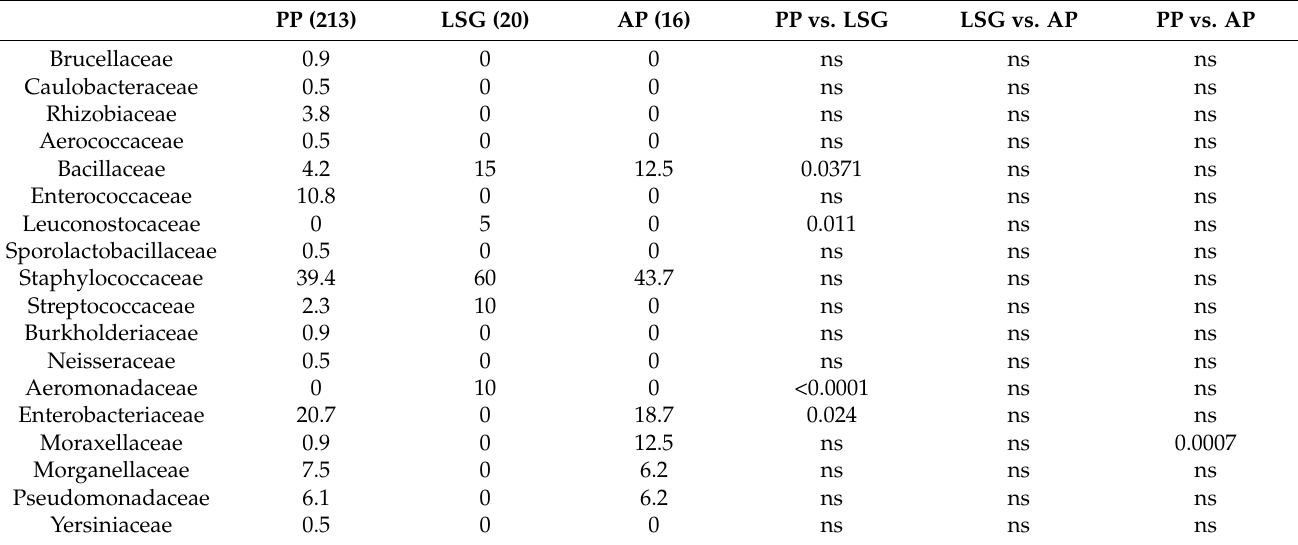
Table 3. Relative abundance (%) of cultivable bacteria at the family level according to lactation period. PP